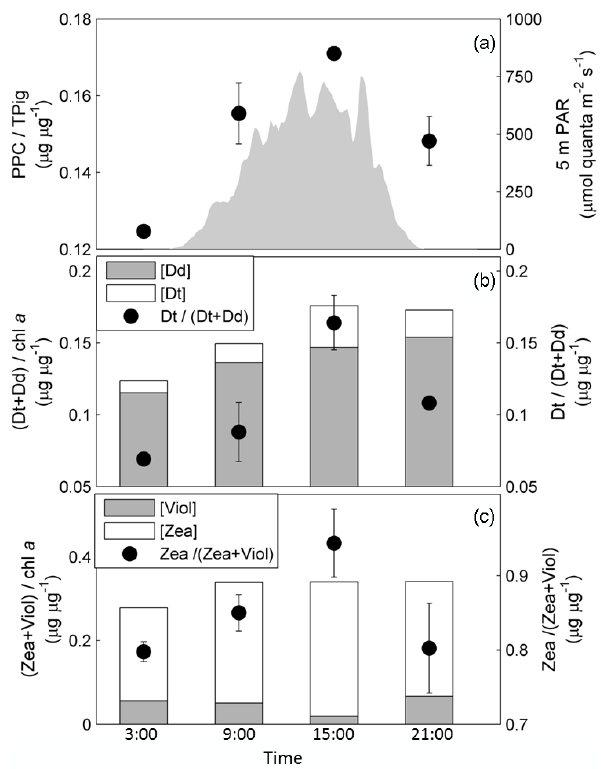
Figure 5. Diurnal changes in pigment ratios. Panel (a) shows changes in the abundance of all photoprotective pigment (PPC), rel- ative to the total pigment present (TPig) at each time point. See Table 2 for a definition of pigment groups used to derive these ratios. Panel (b) shows relative changes in the abundance of the chromophyte xanthophyll-cycling pigments Dd and Dt, normalized to [chl a ]. Changes in the de-epoxidation state ration (DES ra- tio = Dt / (Dt + Dd)), also shown in (b) , indicate the extent of active photoprotective energy dissipation through xanthophyll cycling in the pigment antenna. Similarly, panel (c) shows xanthophyll cycling pigments Viol and Zea, specific to prasinophytes and chlorophytes. Error bars are the range of values from two replicate samples taken at each time